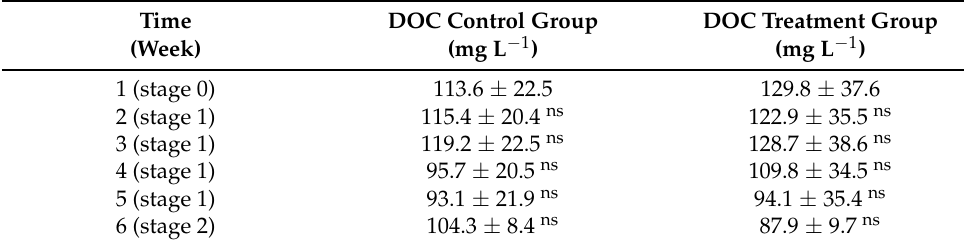
Table 1. Dissolved organic carbon (DOC) in pore water of the control and treatment groups for each sampling week. Amounts represent mean values over all core depths.